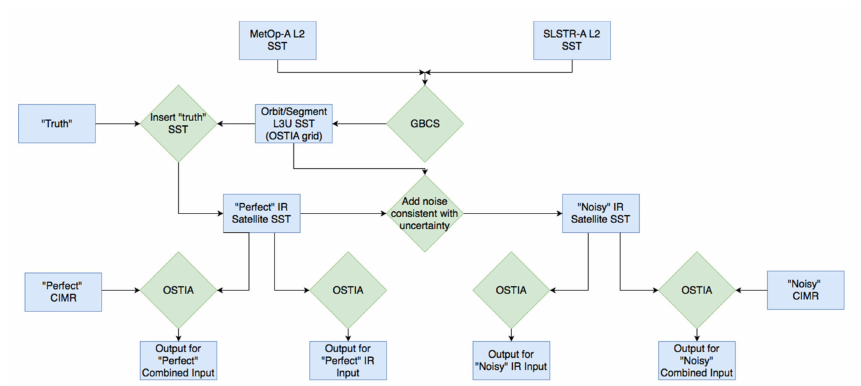
Figure 2. Processing steps involved in generating the synthetic CIMR data.